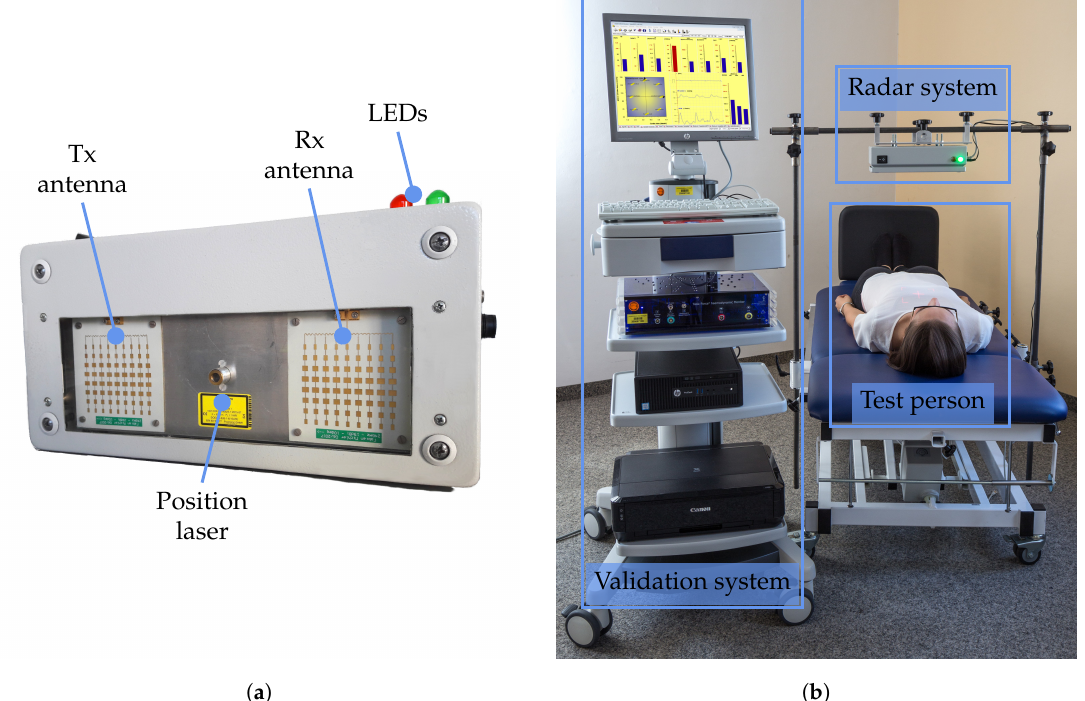
Figure 6. Photographs of prototype and validation systems. ( a ) Photograph of the radar system prototyp; ( b ) Photograph of the study